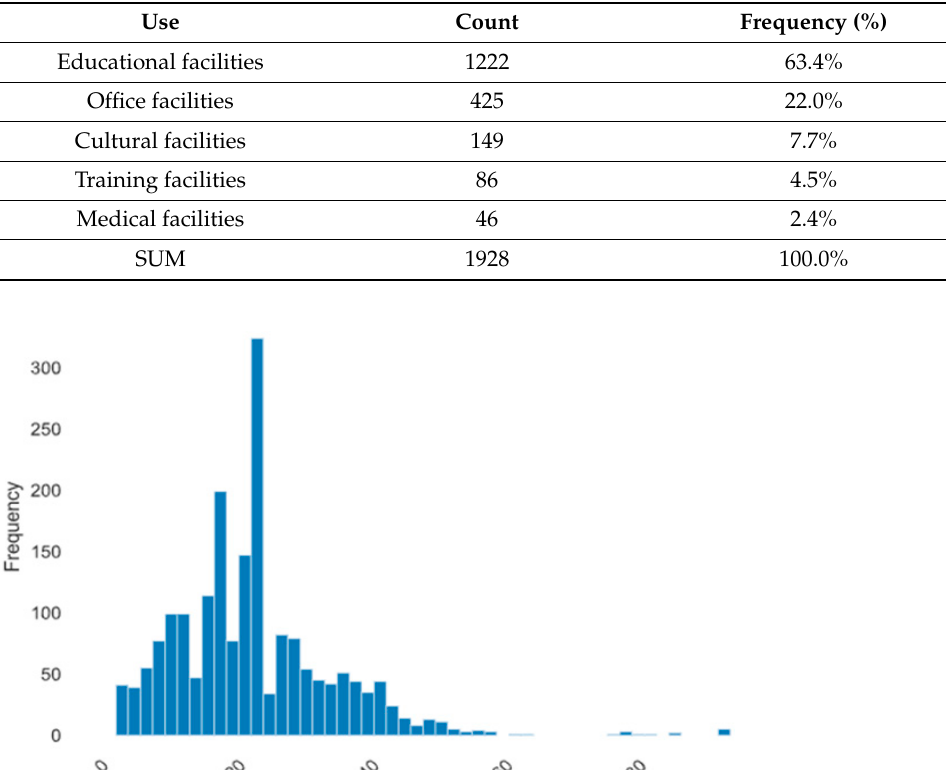
Table 4. Proportions by the use of public buildings subject to energy usage analysis.